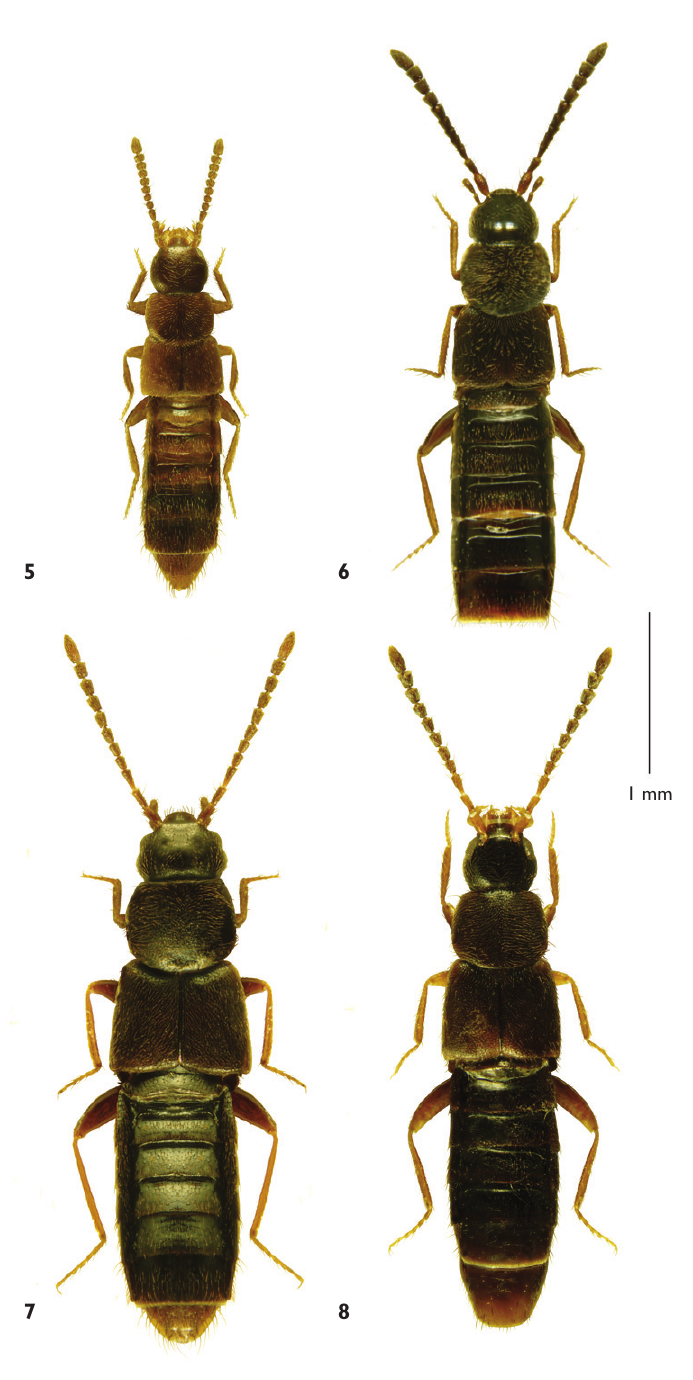
Figures 5–8. Schistoglossa species, dorsal images: 5 S. hampshirensis 6 S. sphagnorum 7 S. carexiana 8 S. blatchleyi